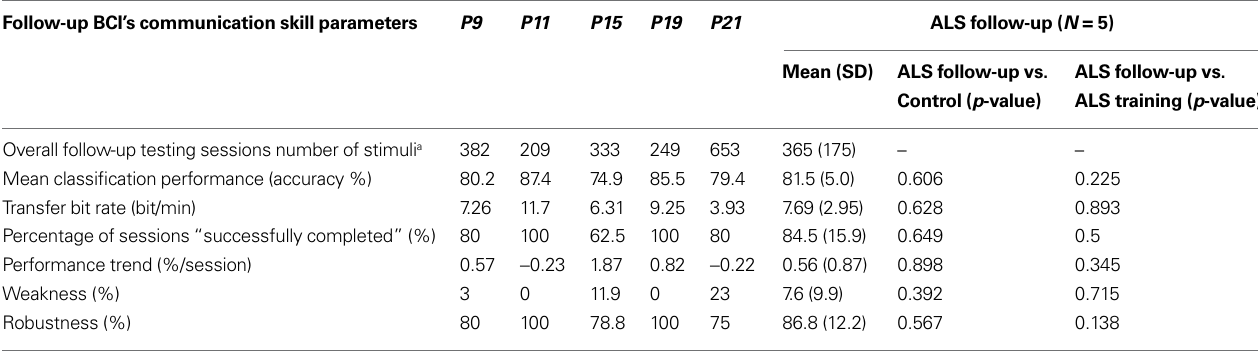
Table 8 | BCI measures during follow-up test (i.e. 10 sessions: FU1 and FU2).